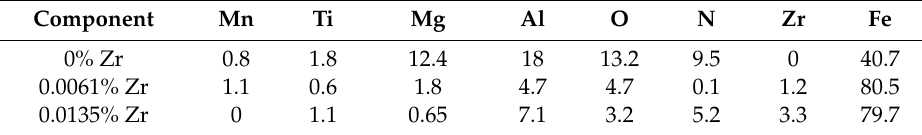
Figure 12. Morphology of tensile fracture of weld metal ( a ) 0%Zr ( b ) 0.0061%Zr ( c ) 0.0135%Zr. Table 8. Inclusion composition of tensile